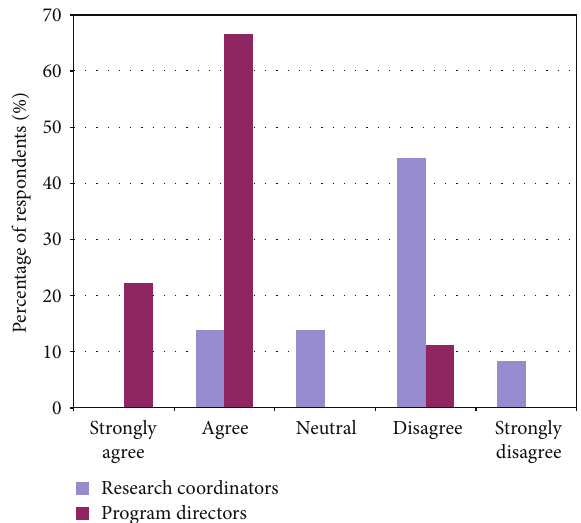
Figure 7: Comparing responses of program directors and research coordinators regarding trainees’ abilities in navigating ethics in research.